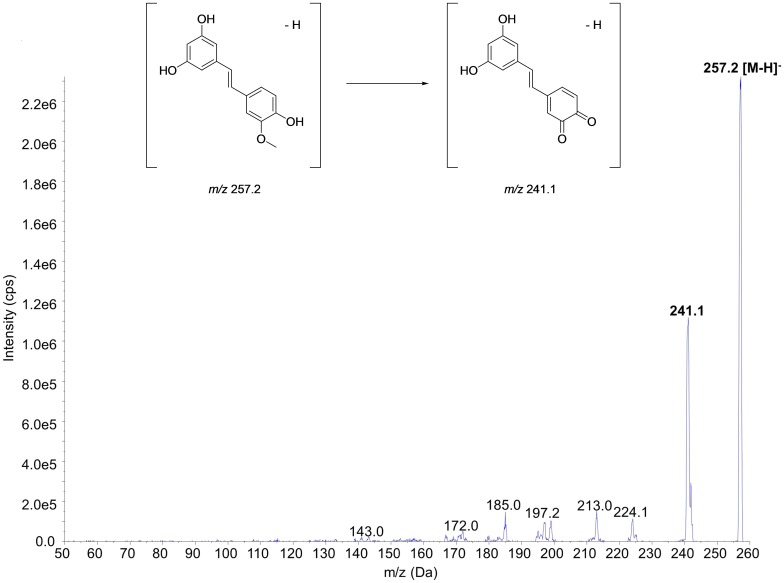
MS/MS spectra of isorhapontigenin and proposed fragmentation pattern of m/z 257.2 → 241.1 transition.